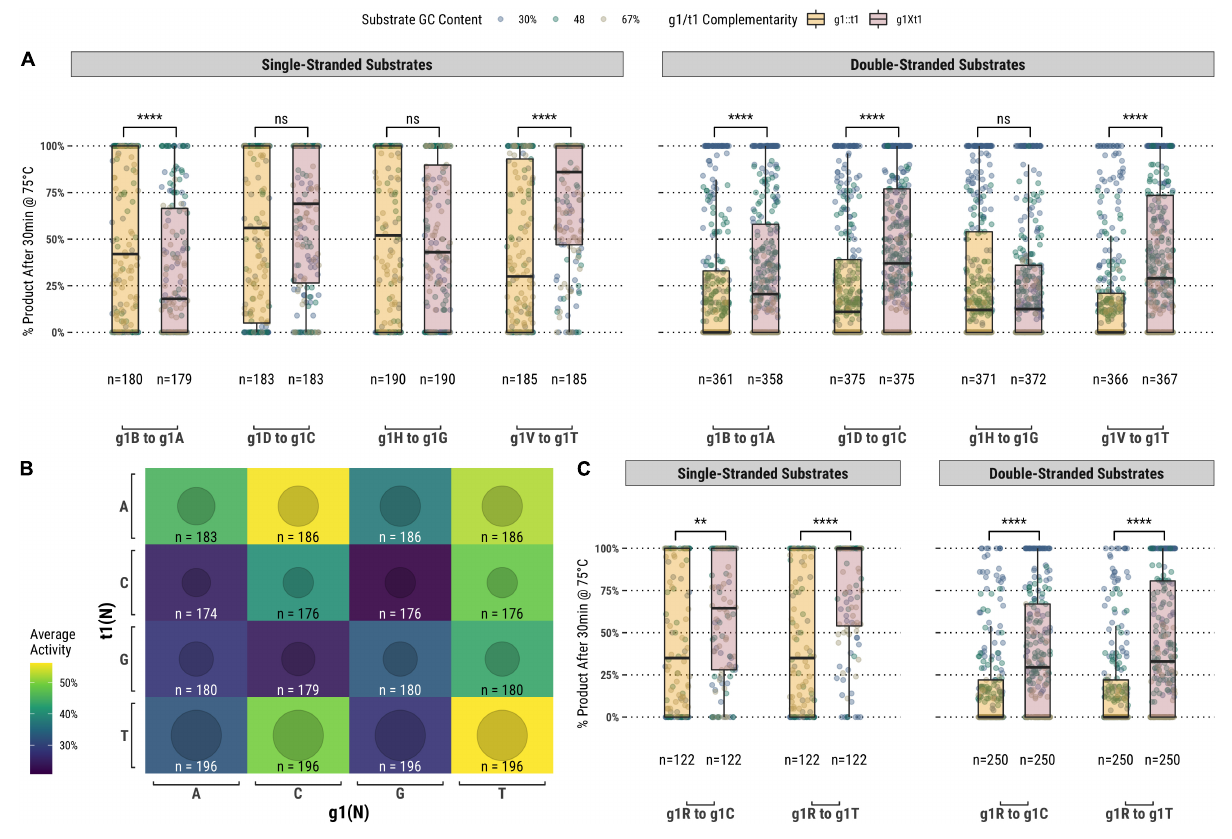
FIGURE 3 | (A) Comparison of fully-complementary g1B/D/H/V guides to partially-complementary (g1 not complementary to t1) g1A/C/G/T guides. (B) A heatmap comparing the average activity of all g1-t1 combinations with single- and double-stranded substrates. (C) Comparing partially-complementary g1C and g1T guides to the same population of fully-complementary g1R guides. Boxplots have been annotated for statistical significance between relevant groups using the following labels: ns (not significant) for p > 0.05; ∗∗ for p ≤ 0.01; and ∗∗∗∗ for p ≤